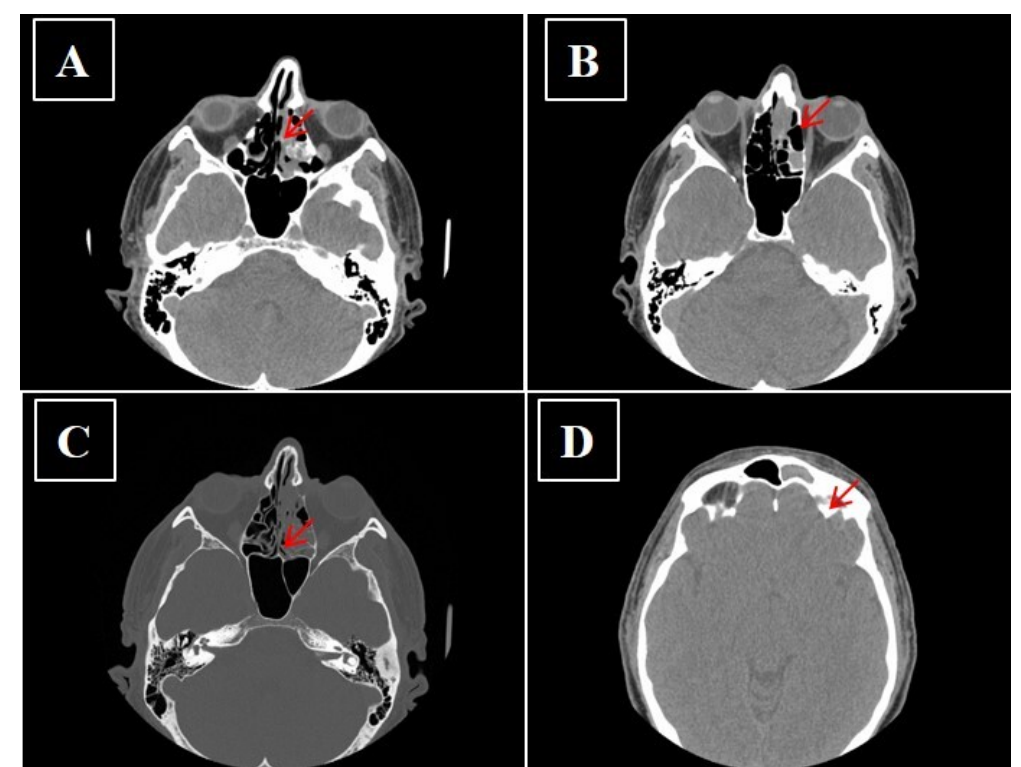
Figure 5. ( A , B , C , D ) No-contrast media CT showing sinonasal neuroendocrine tumors—MENs of ethmoidal cells and to left frontal sinus before surgery (arrow).